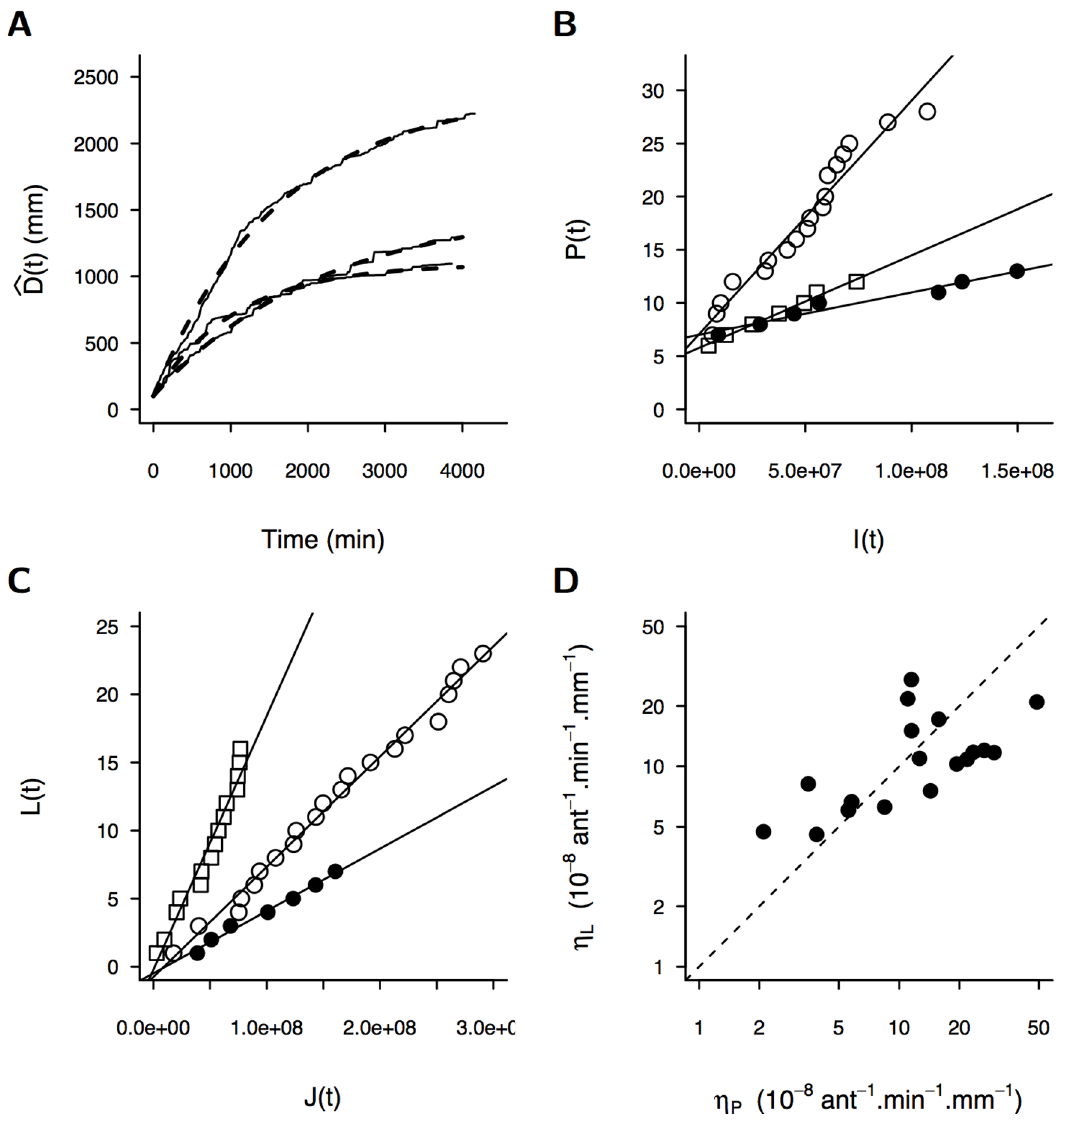
Figure 2. Quantification of the parameters of the digging dynamics from experimental data with A(0)=200 workers. (a) Ant activity parameters ( w and j ) are retrieved from the evolution of the dug length D ( t ) : three typical experimental cases are shown as solid lines and their corresponding predictions by the model as dashed lines (see also fig. S1 for all experimental results). (b, c) The rates of initiation of new peripheral nodes g P and of new lateral nodes g L are retrieved respectively from (b) the regression slope of the number of peripheral nodes P ( t ) as a function of e { j i D t ^ P ( i D t ) D t and (c) the number of lateral nodes L ( t ) as a function of J ( t ) ~ P A g (0) P I ( t ) ~ A (0) P i each of the three experiments shown in (a)). Regressions for all cases can be found in fig. S2 and S3. (d) The rates of initiation of new lateral g L and peripheral g P nodes converge to a common value (one symbol per experiment, dashed line: y ~ x ).